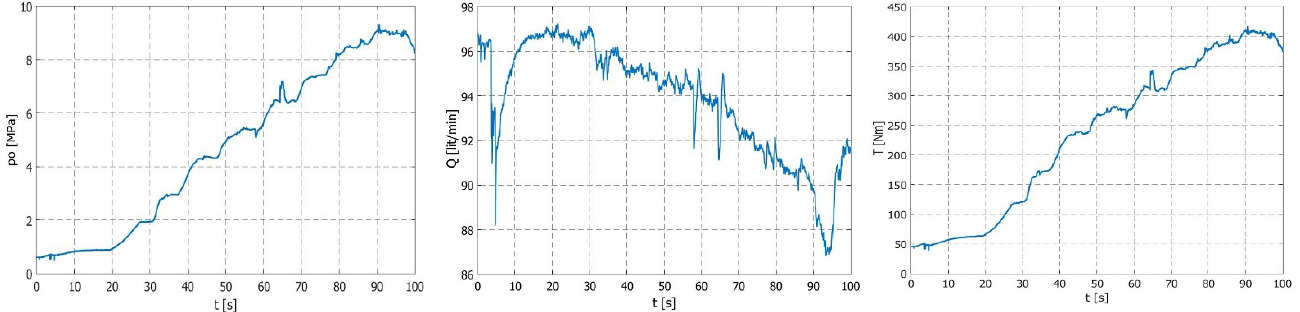
Figure 5. Diagram of dependence of the output pressure, working fluid’s flow rate, and torque of the pump shaft over time in the IR1 operating mode.